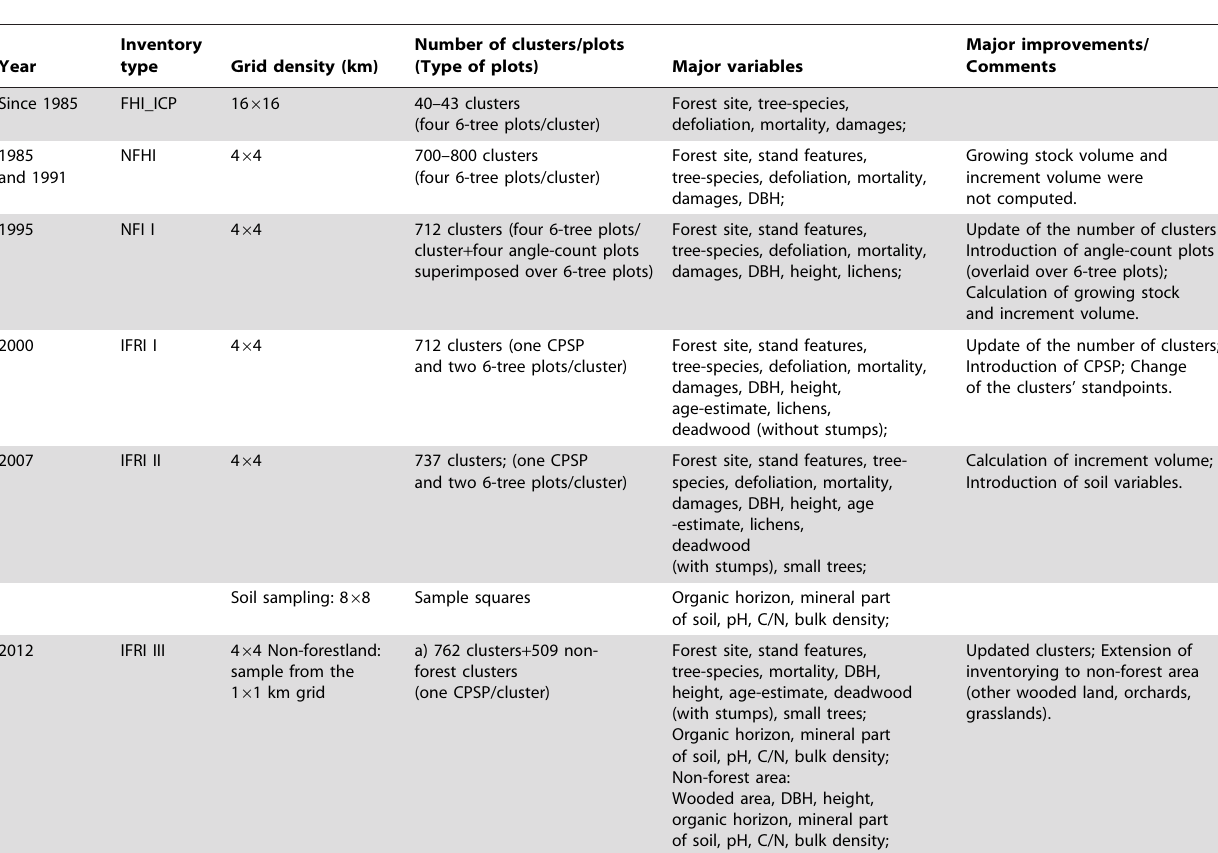
Table 3. Historical development of large-scale forest resource inventory in